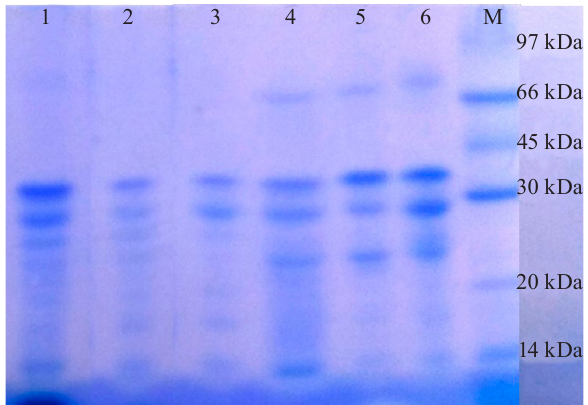
Figure 6 Electrophoregramme samples: sourdough before fermentation: SMP = 30% (1), SMP = 60% (2), SMP = 90% (3); sourdough after fermentation: SMP = 30% (4), SMP = 60% (5), SMP = 90% (6), and the marker (M)